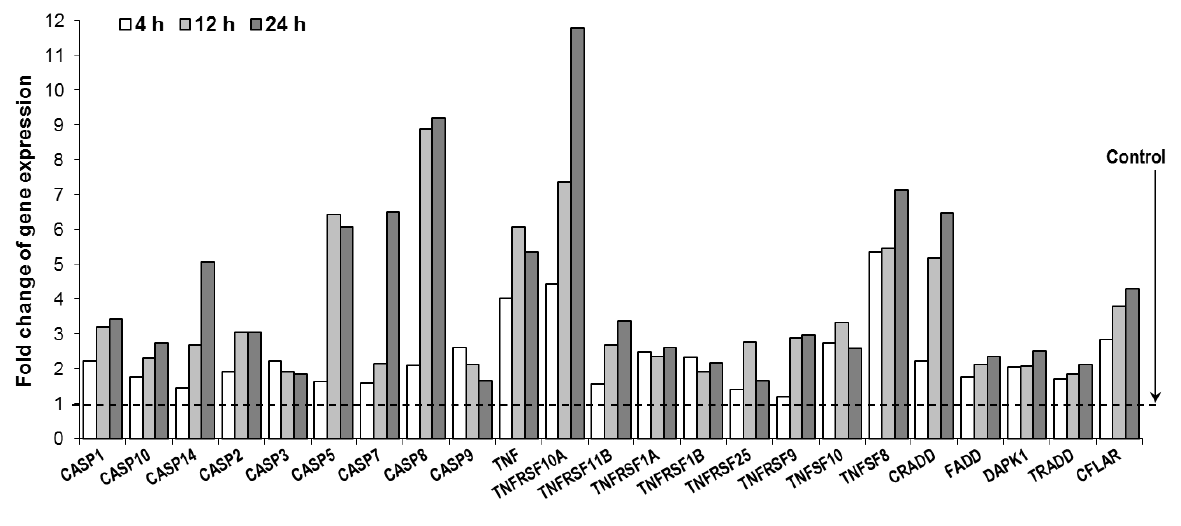
Figure 6. Oplopantriol A (OPT A, 10 μM) promotes changes in selected